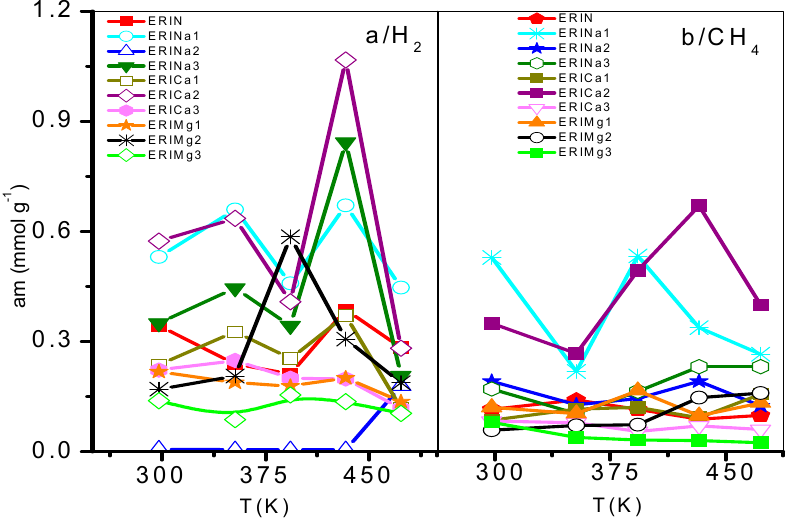
Figure 10. Saturation adsorption limit of: ( a ) H 2 and ( b ) CH 4 on ion exchanged erionites.